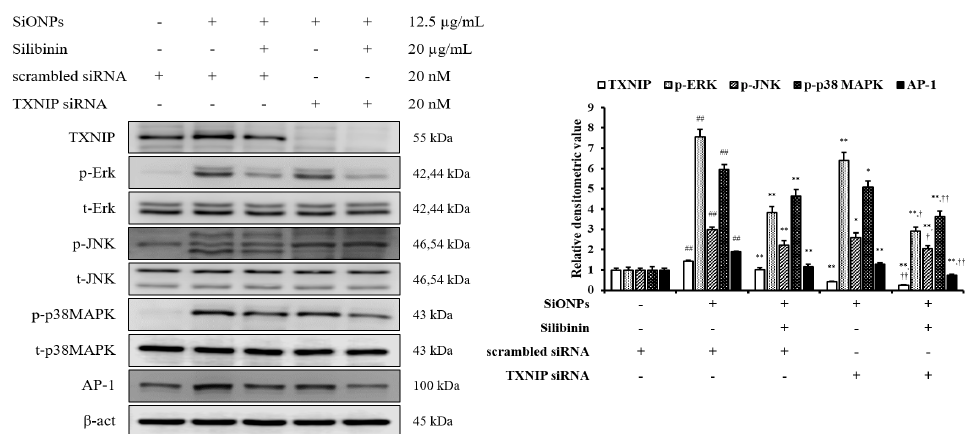
Figure 3. Effects of TXNIP in the effects of silibinin on SiONPs-induced NCI-H292 cells. Protein expression was determined by Western blotting analysis, and its densitometric value was assessed. Data are shown as means ± SD ( n = 3). ## p < 0.01 vs. non-SiONPs-induced NCI-H292 cells, * , ** p < 0.05 and < 0.01 vs. SiONPs-induced NCI-H292 cells, respectively, † , †† p < 0.05 and < 0.01 vs. silibinin-treated NCI-H292 cells induced by SiONPs, respectively.